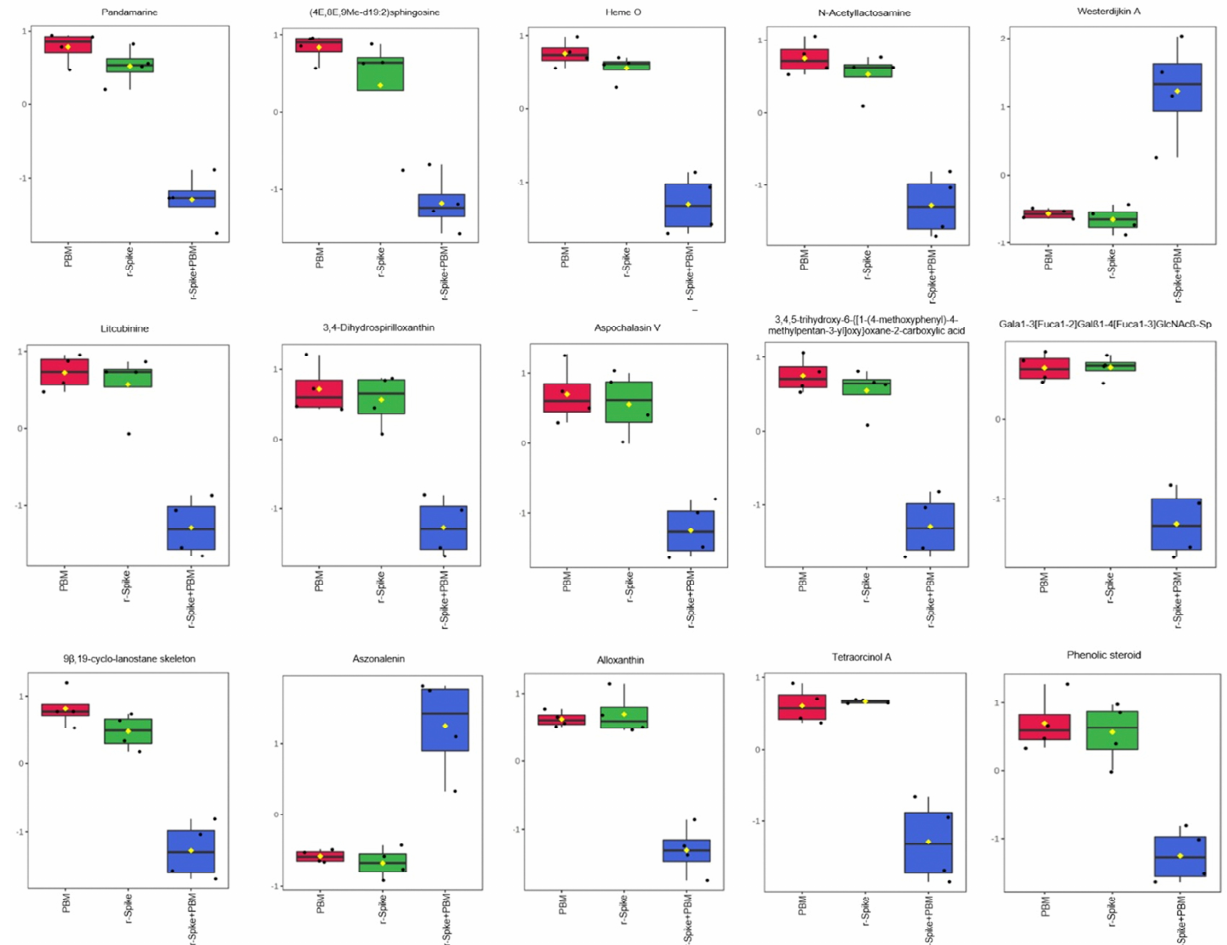
Figure 5. Boxplot plots of the most critical metabolites to differentiate the PBM, rSpike, and (rSpike + laser) after 6 h of treatment. Boxplot graphs referring to the 15 primary metabolites differentially expressed between groups after 6 h of treatment.